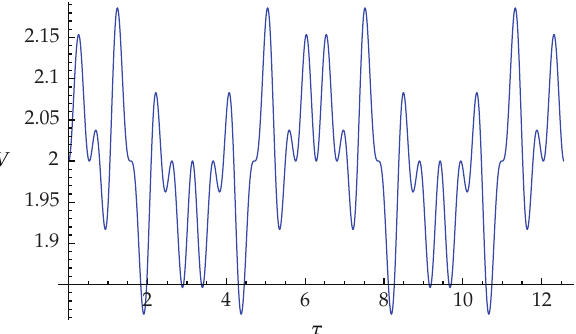
Figure 3: The evolution of the volume of the trefoil knot universe with respect to the cosmic time τ for (cid:2) 3.6 (cid:3) .